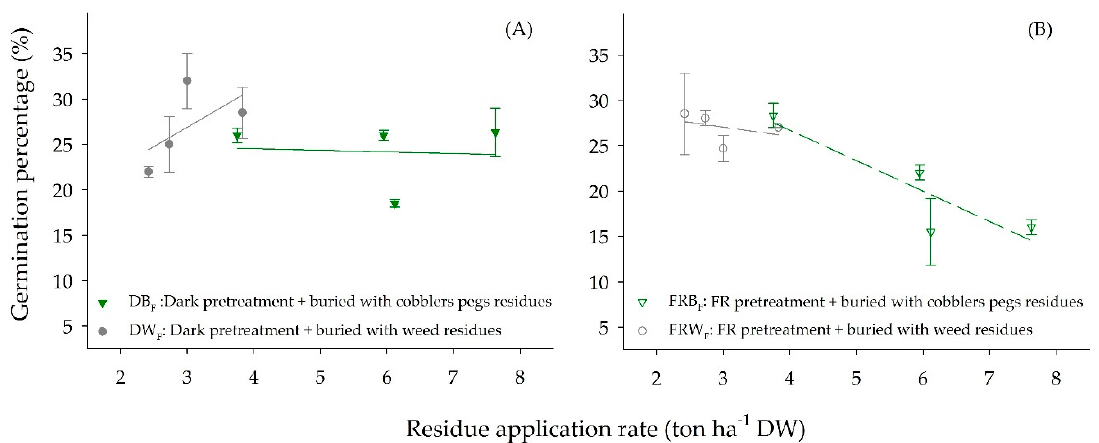
Figure 9. The relationship between the residue application rate and Cobbler’s pegs seed germination for ( A ) dark pretreatment and ( B ) FR pretreatment. The Pearson’s correlation coefficients of DB F , DW F , FRB F and FRW F were − 0.0736, 0.596, − 0.889 and − 0.369, respectively.